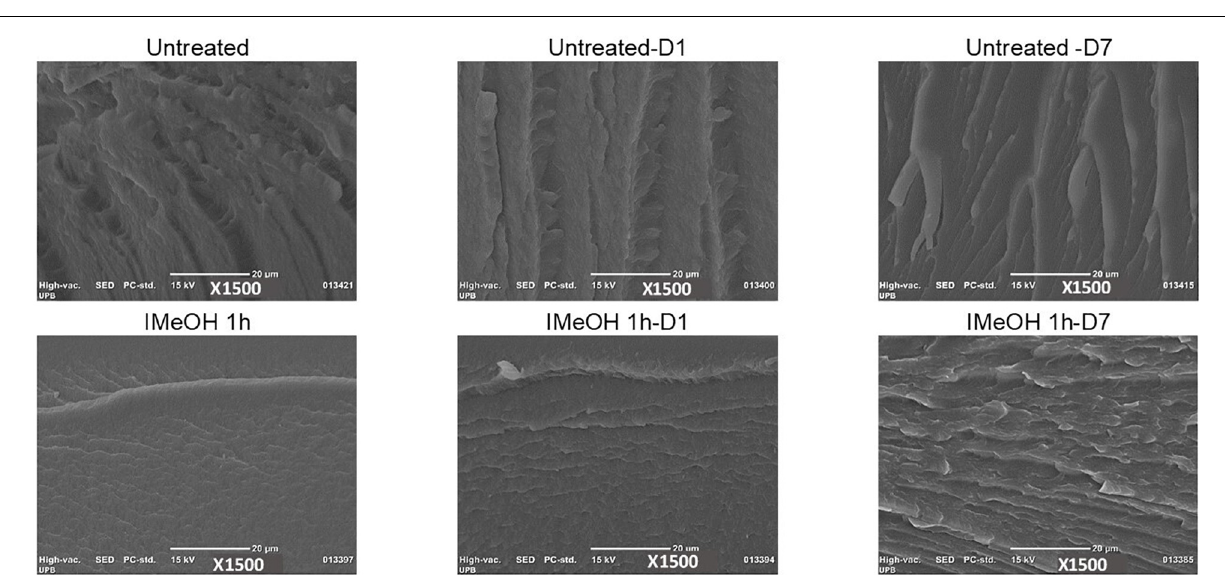
FIGURE 7 | SEM cross-section untreated, treated films IMeOH 1 h, before and after the